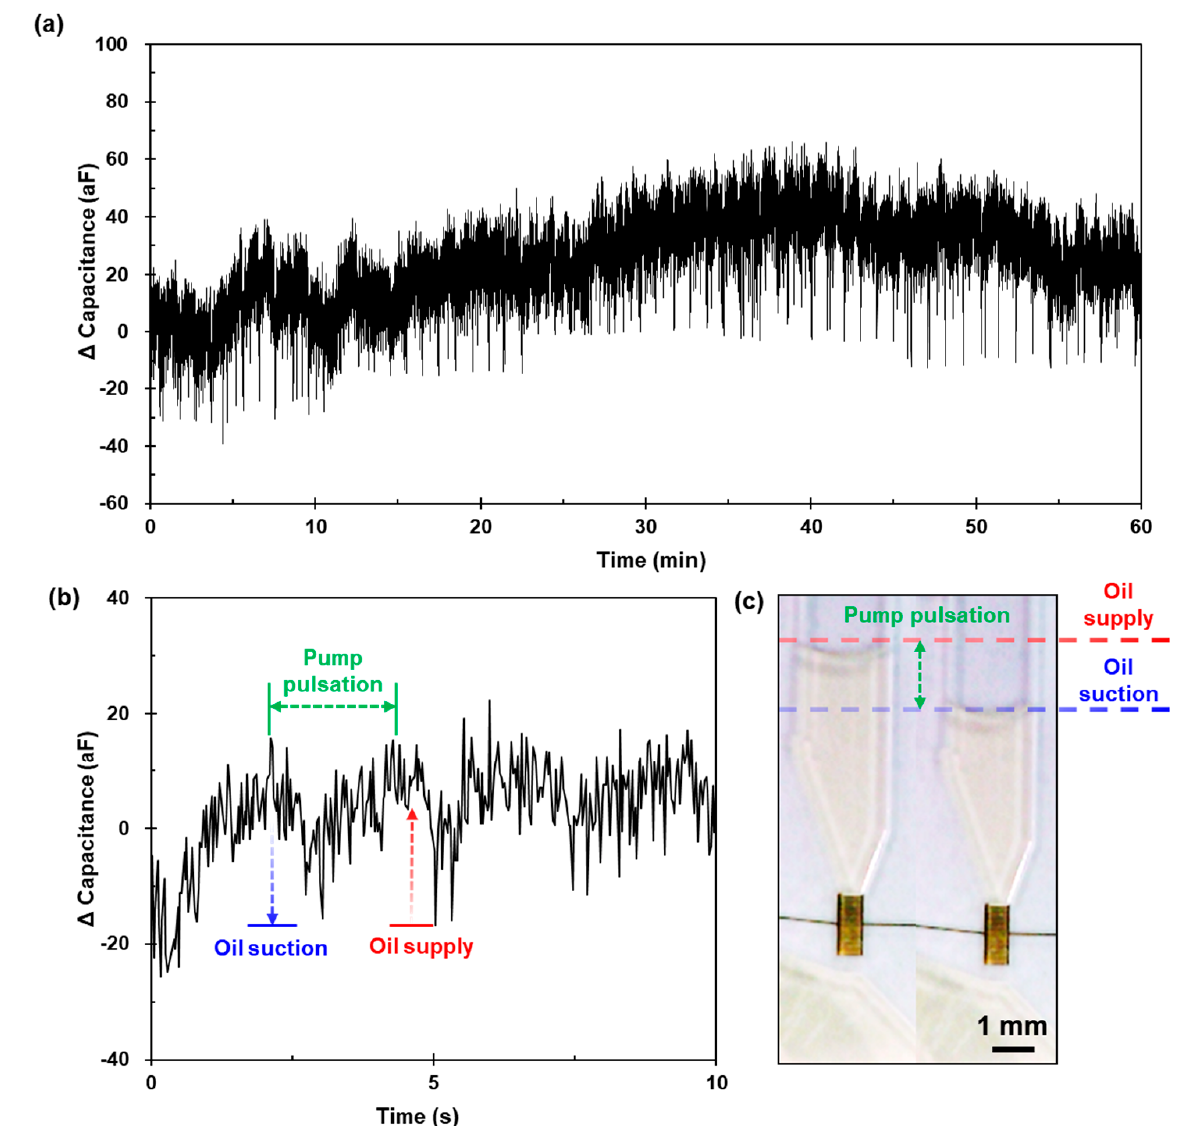
Figure 13. ( a ) Measured capacitance signals during operating the pump system for 60 min, ( b ) close-up view of 10 s interval, and ( c ) video frames showing the fluctuating liquid interface according to peristaltic pump operation.